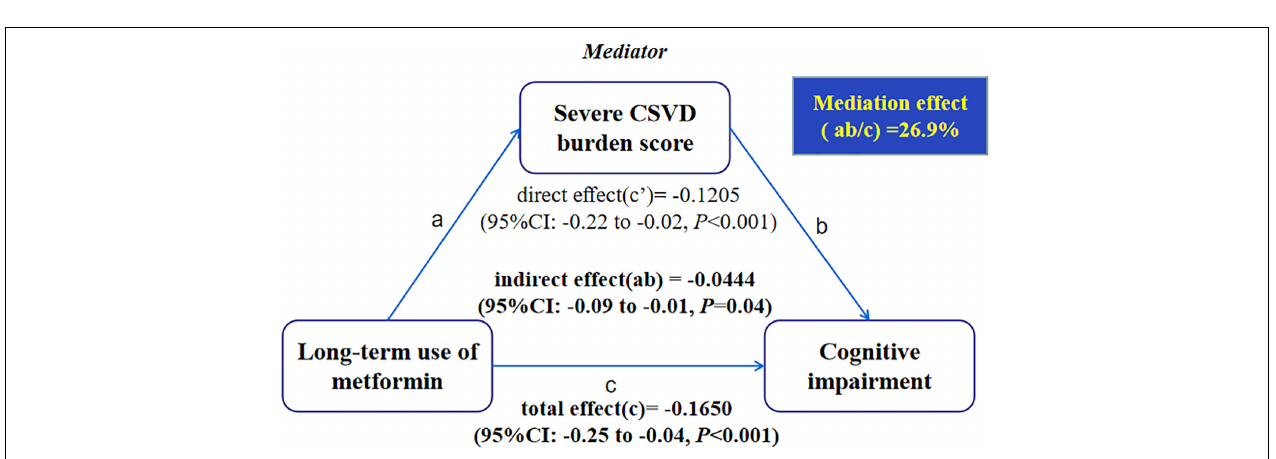
FIGURE 2 | Ordinal logistic regression analysis for the associated factors with total cerebral small vessel disease (CSVD) burden.